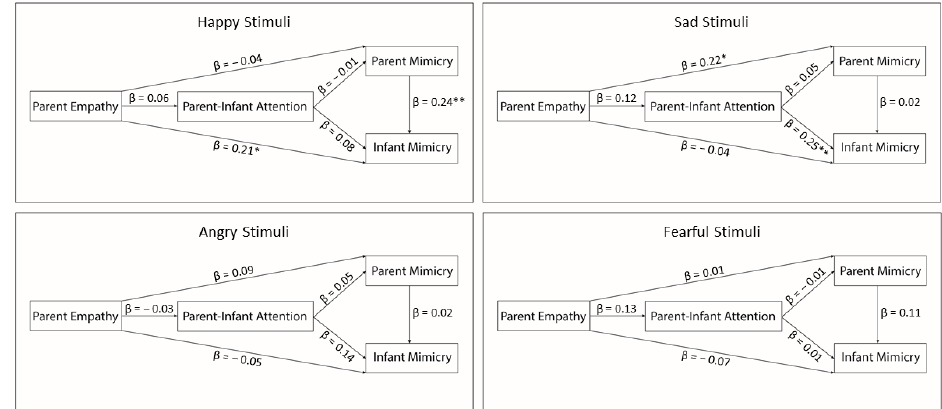
Figure 5. Path coefficients, which indicate the strength and the directions of the relations between the experimental constructs, are reported in standardized metric, and were considered significant at the α = 0.05 level. * p < 0.05; ** p < 0.01.